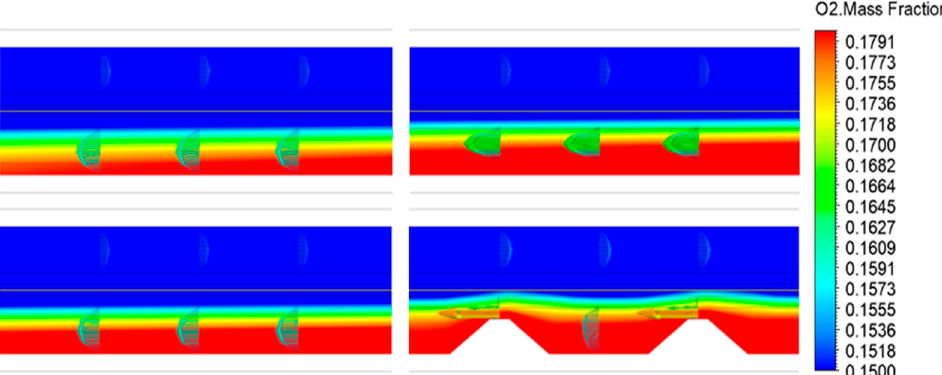
Figure 9. O 2 mass fraction contours: conventional rectangular channels ( above left ); biporous cathode channel ( above right ); porous cathode channel ( below left ); porous and baffled cathode channel ( below right ) at operating current density of 4.0 A · cm − 2 .